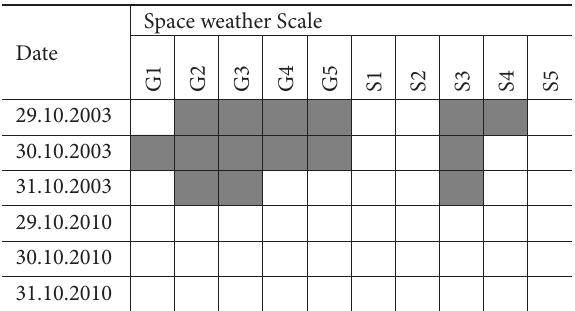
Table 1. Selected solar activity events as an object for experi- mentation Space weather Scale